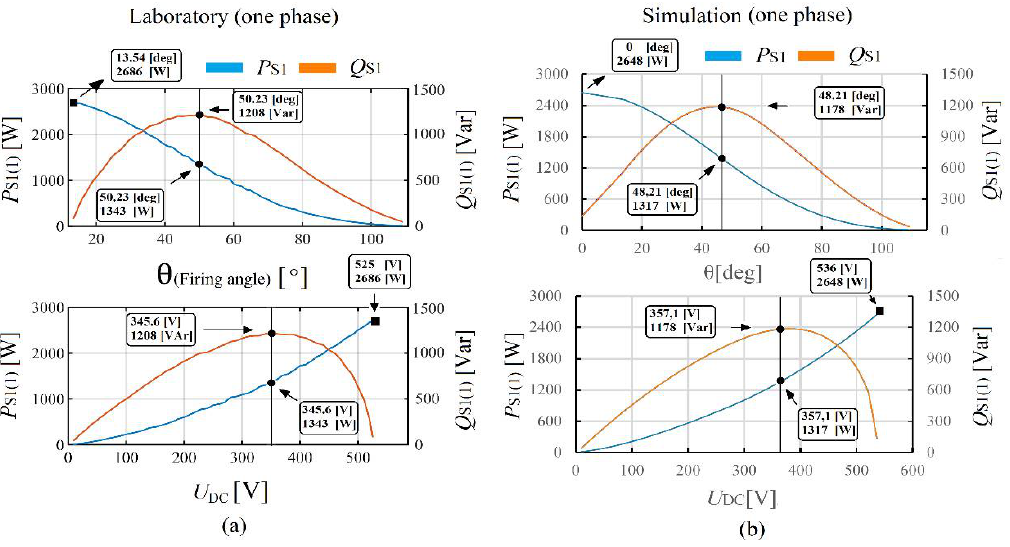
Figure 11. Fundamental harmonic PCC active and reactive powers versus firing angle and versus U DC (one-phase): ( a ) laboratory data; ( b ) simulated data.